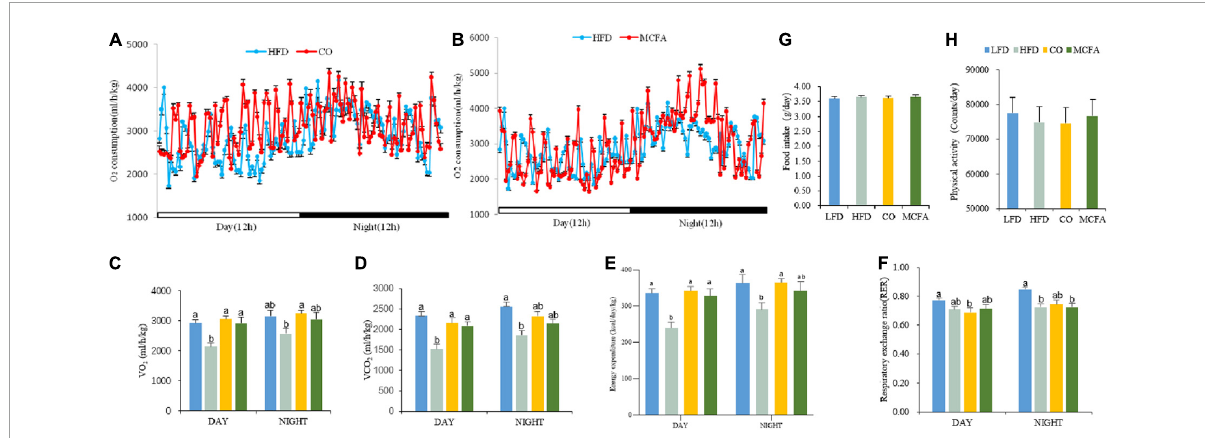
FIGURE3 CO and MCFA increase energy expenditure in obese mice. (A,B) The energy expenditure of the mice treated with either CO or MCFA is examined by measuring the VO 2 over 24 h. Bar graphs represent the average for (C) oxygen consumption and (D) carbon dioxide production, ( n = 10). (E) Energy expenditure. (F) RER (RER = VCO 2 /VO 2 ). (G) Food intake. (H) Physical activity ( n = 10). Values represent means ± SEM. Mean values with different letters are significantly different ( P < 0.05).